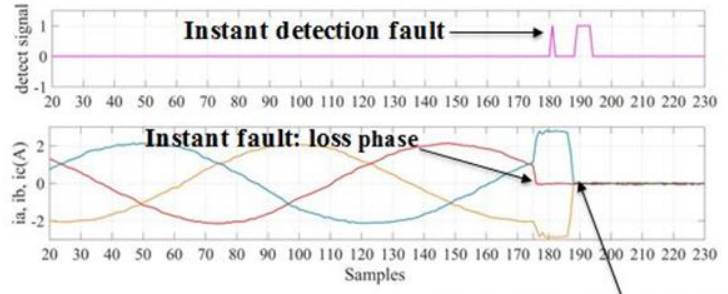
Figure 30. Stator current signal and trip signal for phase loss fault.